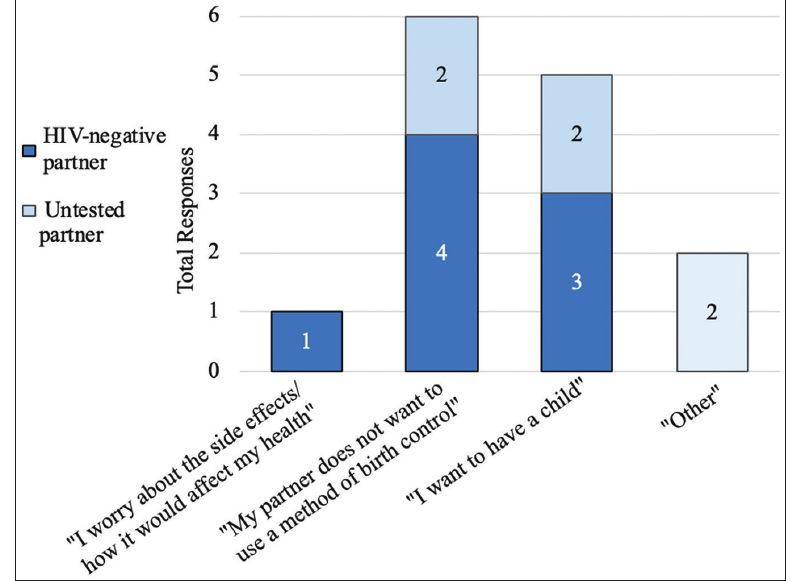
Figure 3: Reasons cited for not using family planning among sexually active women (N=13) Source: One woman with an HIV-positive partner cited “not currently sexually active” as reason, and is therefore not included in this fig - ure. Women were able to choose multiple answers. Other answer options not chosen by women: “It is difficult for me to afford methods of birth control”; “It is difficult for me to access/obtain methods of birth control”; and “I do not know about methods of birth